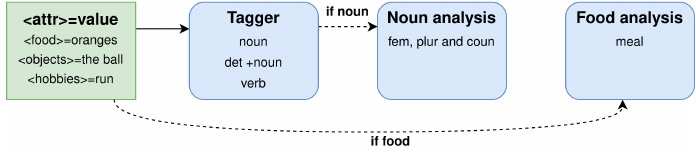
Figure 7. Entity analysis for